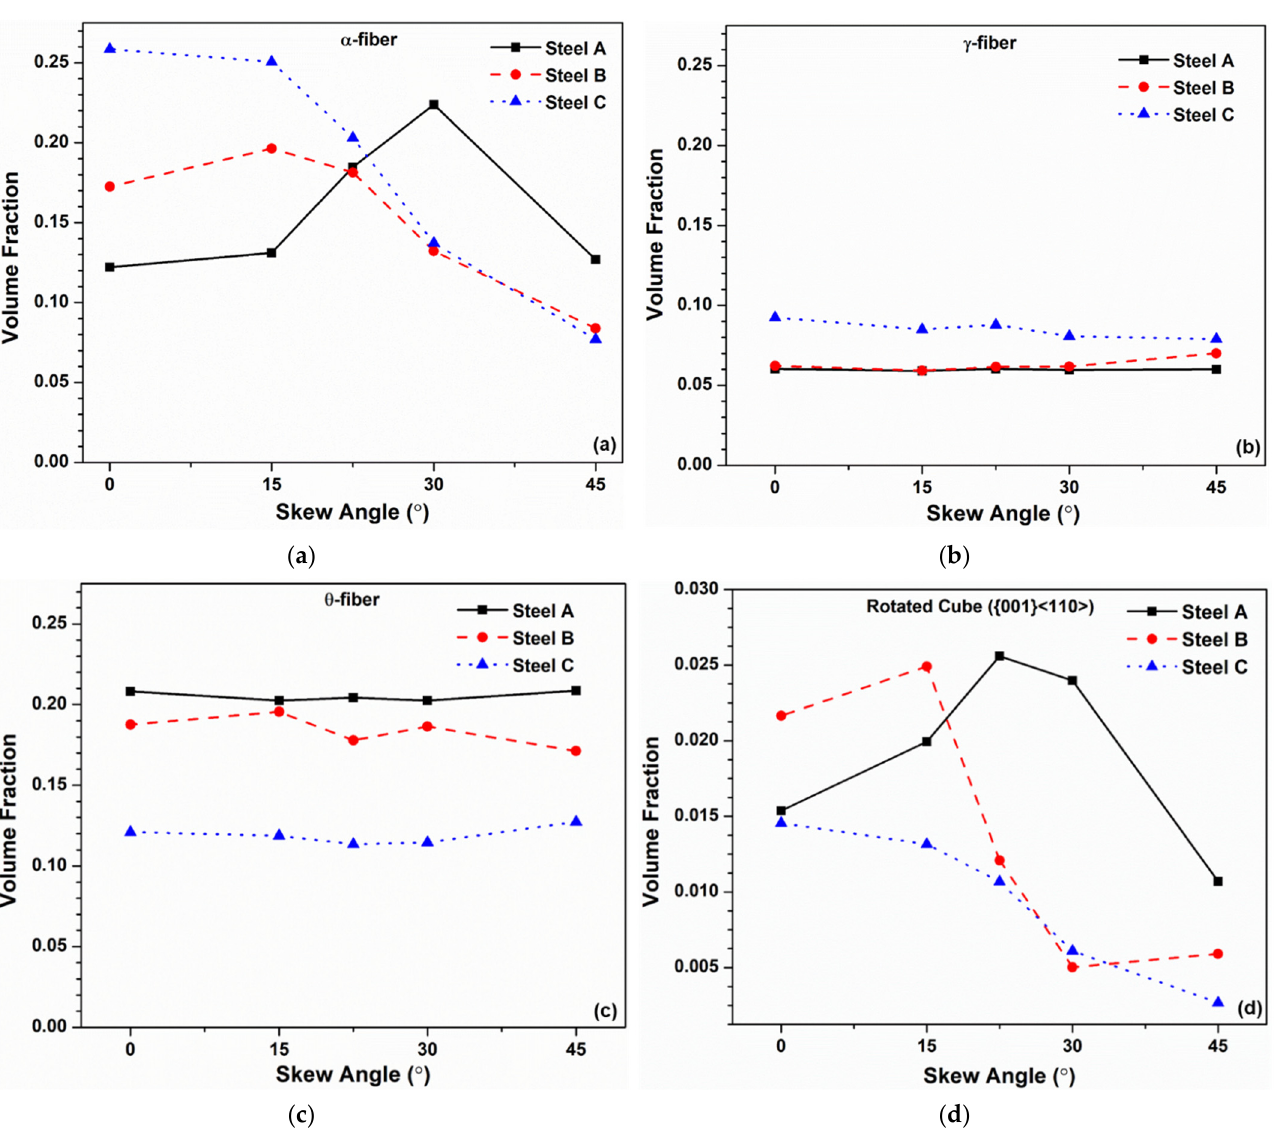
Figure 3. Variations of the volume fractions of typical texture fibers: ( a ) α -fiber, ( b ) γ -fiber, ( c ) θ -fiber and the rotated cube component ( d ), with respect to the rotation around the ND.